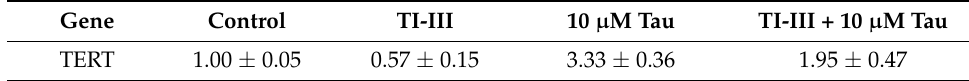
Table 5. Relative gene expression of TERT (fold change).